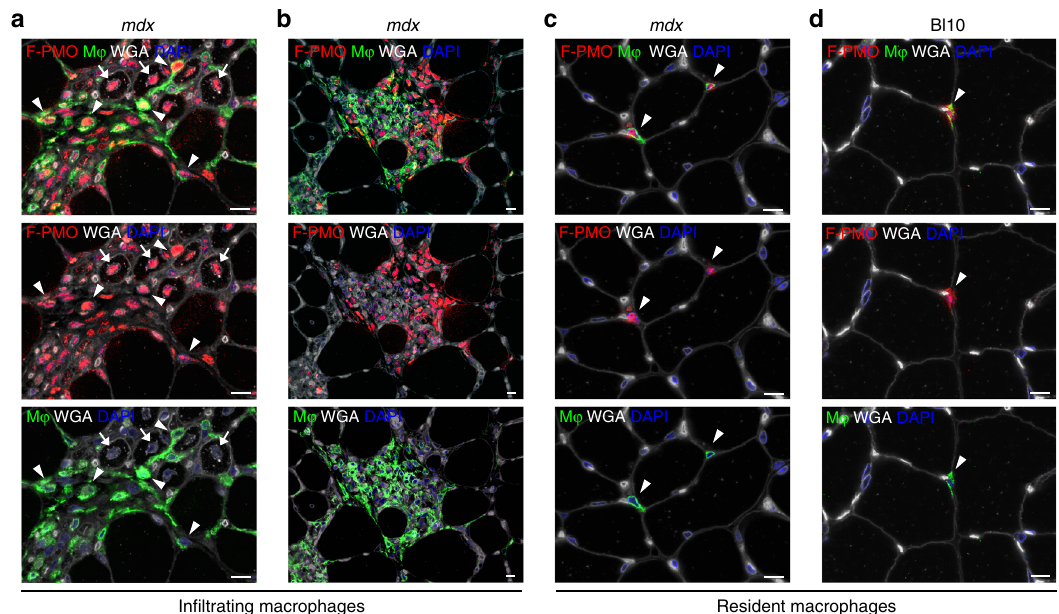
Fig. 4 PMO penetrates in fi ltrating in fl ammatory cells targeting regions of active muscle regeneration. a PMO uptake within in fi ltrating macrophages, targeting areas of regeneration after systemic F-PMO delivery in 4 week mdx mice (400 mg/kg, n = 3); PMO uptake observed within myonuclei is marked by arrow , while PMO-loaded macrophages (M φ ) are marked by arrowheads and immunostained with F4/80. b Widespread PMO accumulation within a large population of in fi ltrating macrophages and other in fl ammatory cells targeting degenerating myo fi bers. c , d Sporadic PMO uptake within interstitial, resident macrophages localized in non-regenerating mdx ( c ) and wild-type ( d ) muscle. Arrowheads mark examples of PMO +ve macrophages. Muscles were analyzed following single injection of F-PMO, mice were euthanized 4 days post-PMO delivery. PMO, red ; macrophage F4/80, green ; DAPI, blue ; WGA, white ; scale bars represent 10 μ